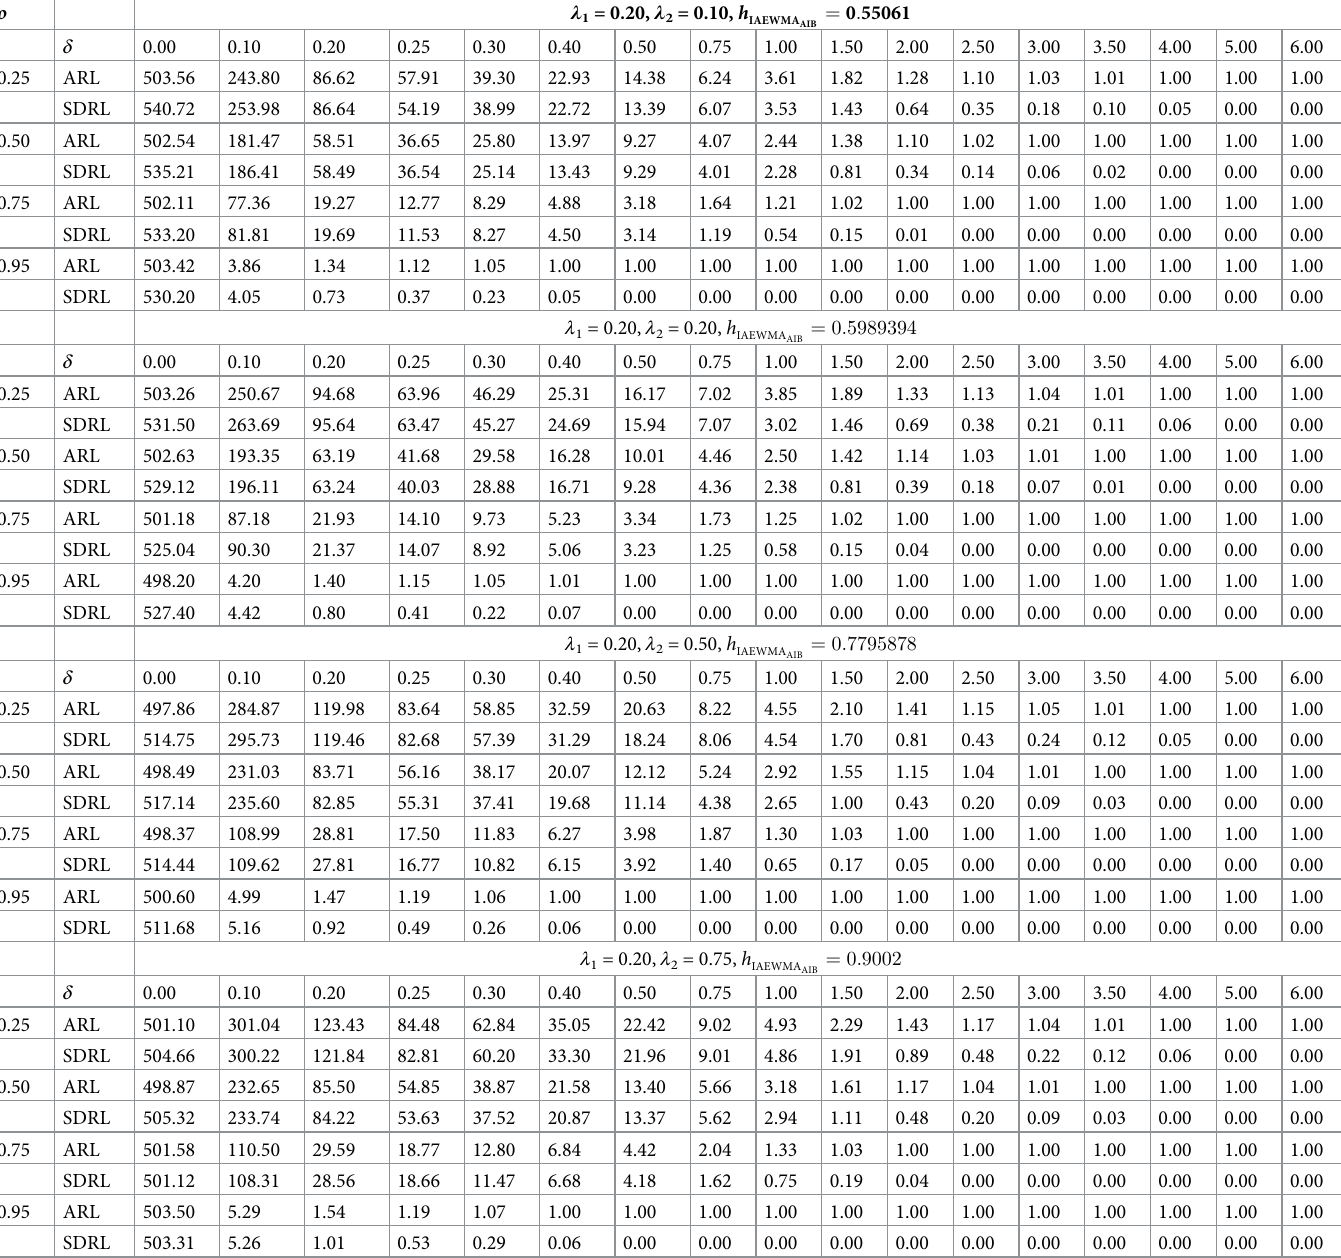
Table 2. The run-length profile of proposed IAEWMA AIB control chart under various choices of λ 2 when λ 1 is moderate and ARL 0 = 500.